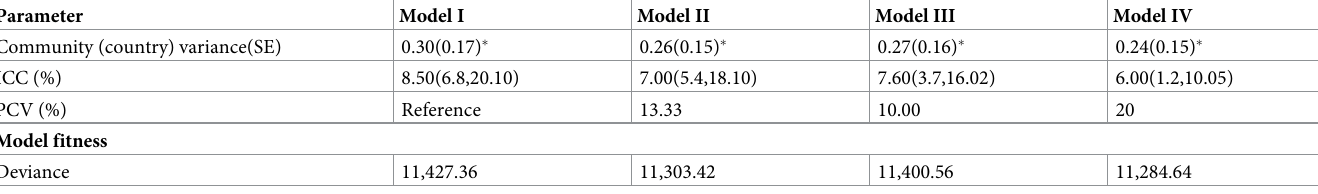
Table 3. Random effect and model